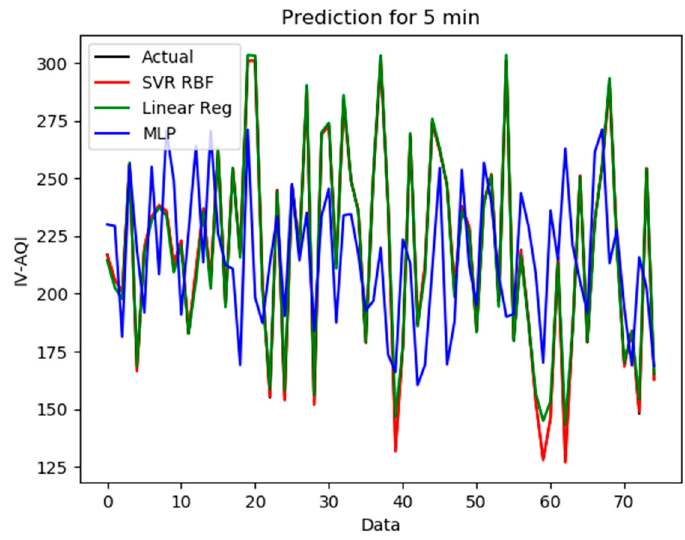
Figure 10. The prediction for the month event in SVR, LR, and MLP.